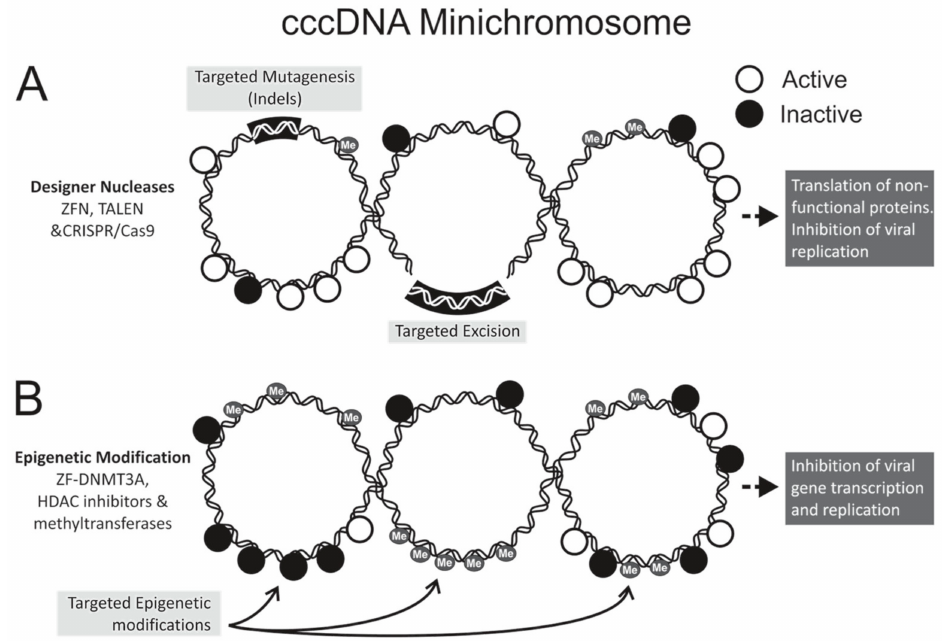
Figure 1. Strategies for hepatitis B virus (HBV) gene editing and epigenome modifications. The covalently closed circular DNA (cccDNA), which may be methylated, forms a minichromosome with transcriptionally active (open circles) and inactive (closed circles) chromatin. ( A ) Designer nucleases cleave at pre-defined sequences within the HBV genome to effect targeted mutagenesis. Employing multiple nucleases to digest different sequences may lead to targeted excision. Mutated cccDNA may be transcribed, but mutant viral proteins cannot carry out viral replication; ( B ) Epigenetic modification involves conversion of actively transcribed DNA to a transcriptionally inactive state without altering the nucleotide sequence the viral DNA. Targeted modifications occur when DNA-binding domains guide epigenetic effectors to pre-defined sequences of cccDNA. Histone modification and